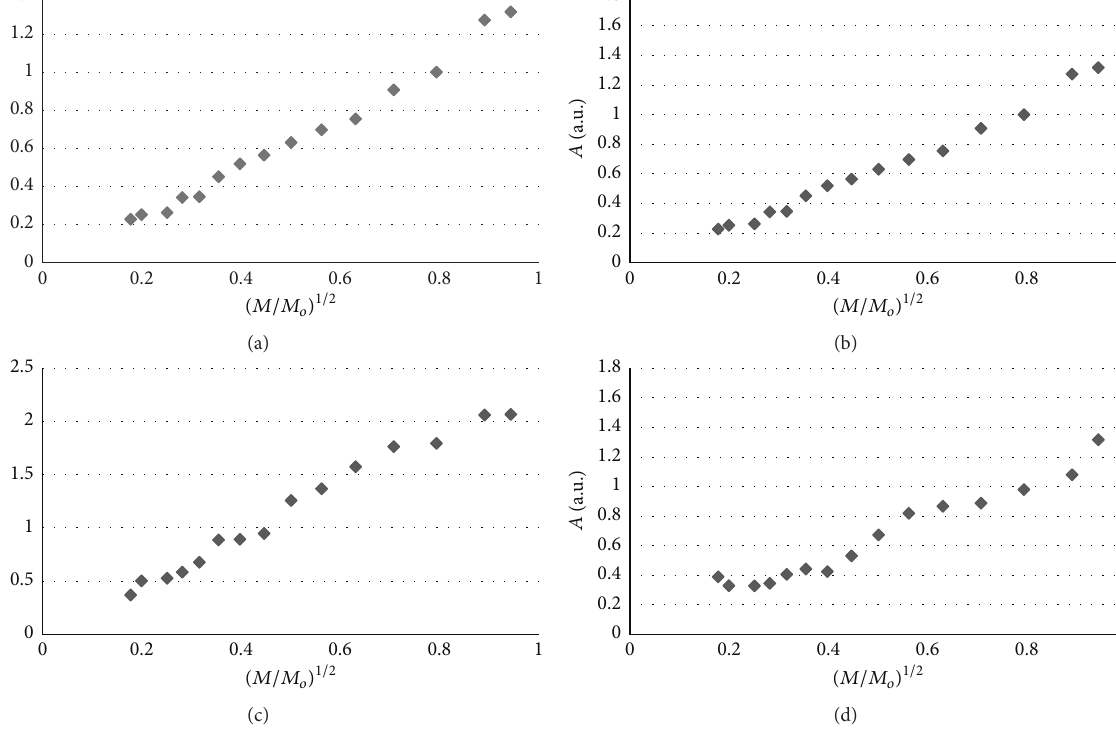
Figure 6: The effect of microwave power ( 𝑀/𝑀 𝑜 ) on amplitudes ( 𝐴 ) of the EPR spectra of UV irradiated urea during (a) 15 minutes, (b) 30 minutes, (c) 45 minutes, and (d) 60 minutes. 𝑀 : microwave power used during the measurement and 𝑀 𝑜 : total microwave power produced by klystron